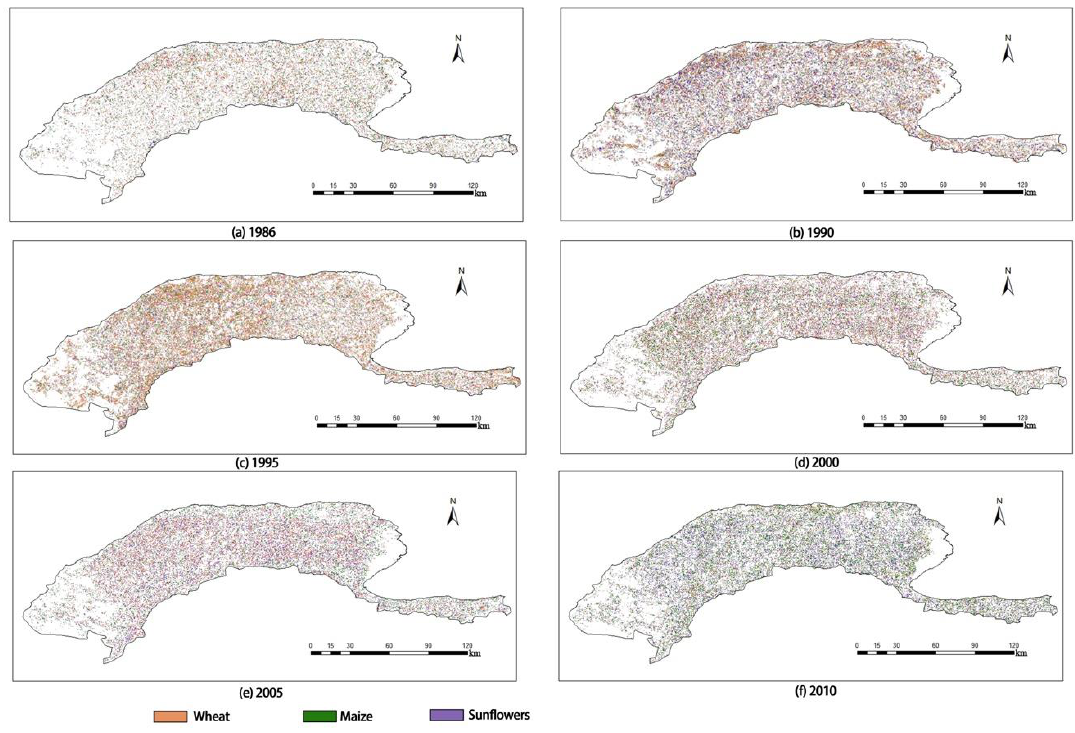
Figure 11. Planting structure classification results of the Hetao Irrigation District in 1986–2010. Table 5. Comparison of the area estimated by remote sensing and the statistical data for maize, wheat, and sunflowers in different years.